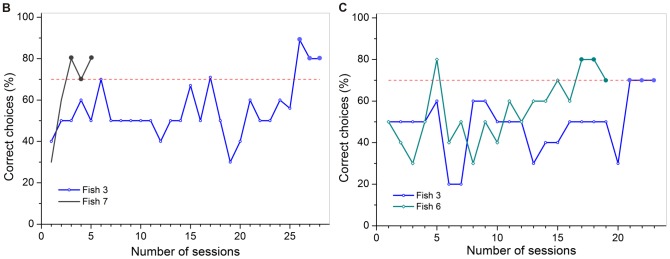
Training achievements for all individuals used in part B and C of experiment 2a.The colored lines display the individual learning success for each fish that reached criterion, shown by the percentage of correct choices per session (à 10 trials). The dashed red line indicates the threshold for the learning criterion at 70 % correct choices. The three sessions necessary to reach criterion (≥70 % correct choices) are highlighted by big dots colored analogous to the individual learning curves.